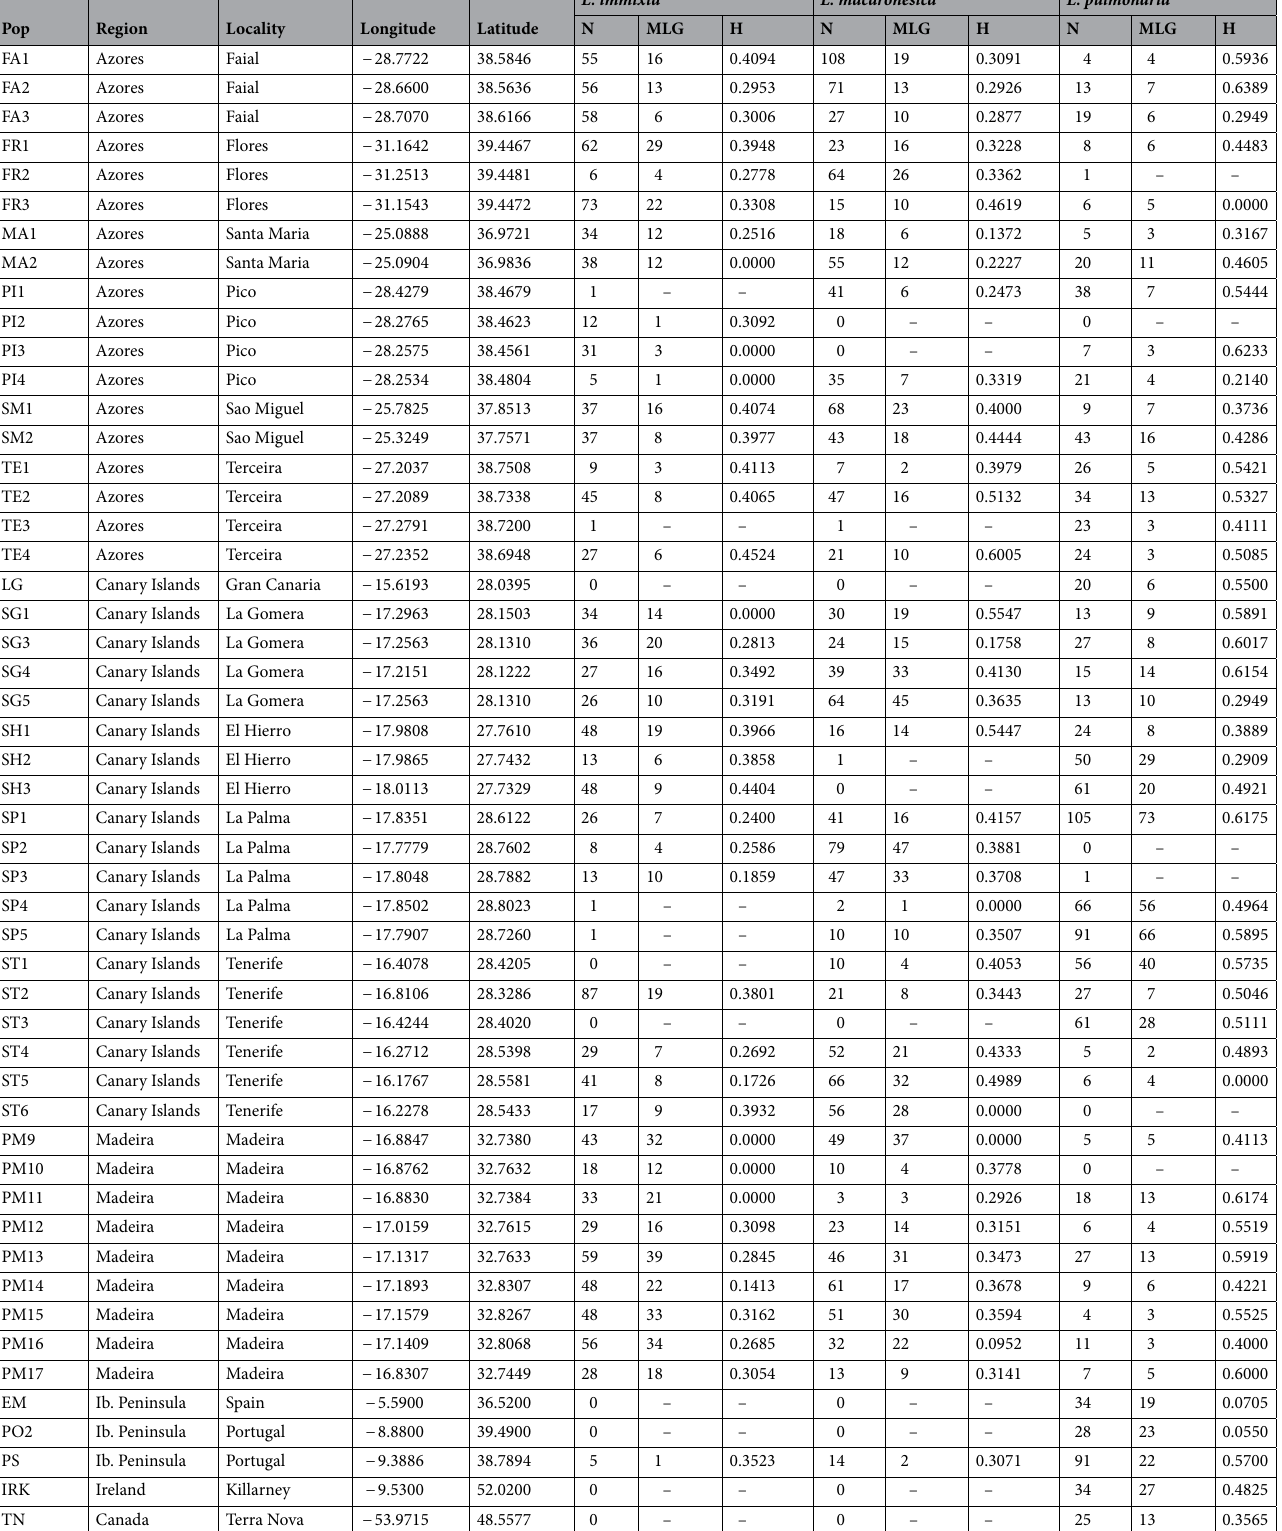
Table 1. Diversity statistics and location information for 51 populations situated in six geographic regions (Azores, Canada, Canary Islands, Iberian Peninsula, Ireland, Madeira) for the lichen-forming fungi Lobaria immixta, L. macaronesica, and L. pulmonaria, based on six fungal microsatellite loci. The table gives locality information and the sample size (N), number of multilocus genotypes (MLG), and Nei’s unbiased gene diversity